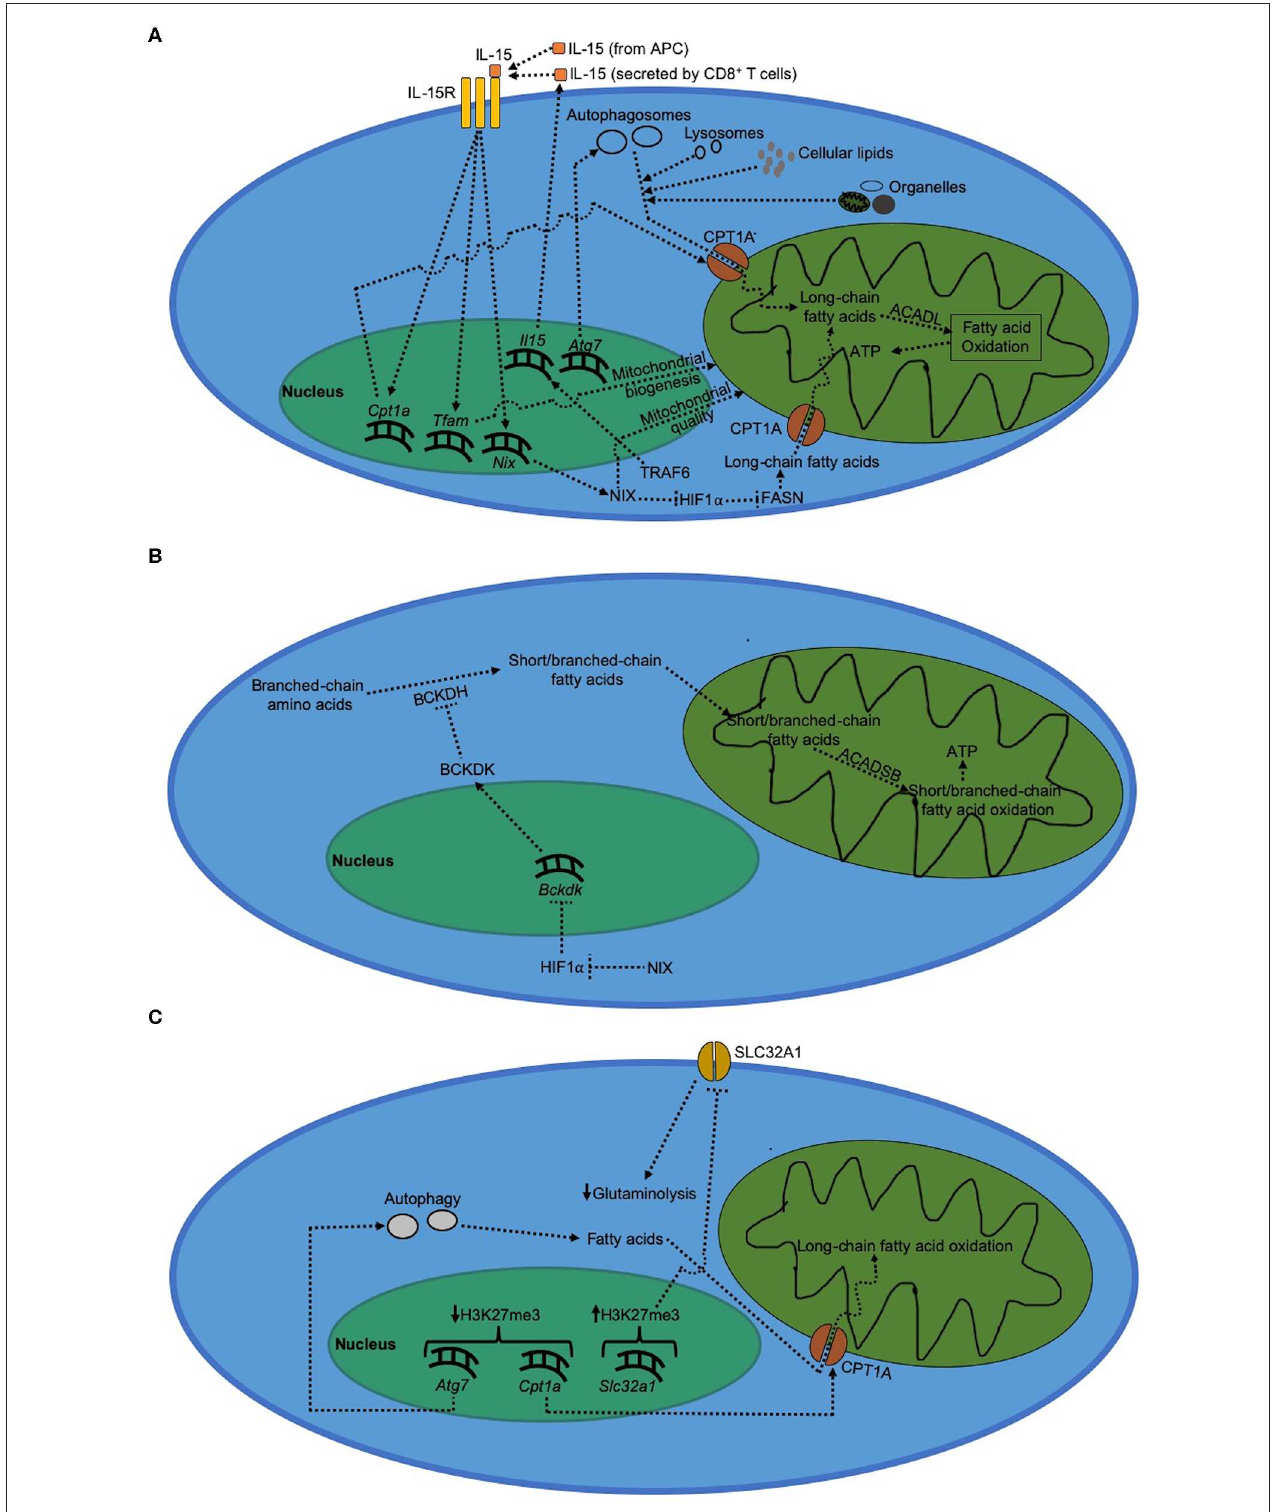
FIGURE 2 | Metabolism in CD8 + T cells during memory formation. (A) Regulation of long-chain fatty acid metabolism during CD8 + T cell during memory formation. Immunological memory formation is characterized by metabolic shift to fatty acid oxidation driven by long-chain fatty acids, which serves to primarily generate ATP. (B) Regulation of short/branched-chain fatty acid metabolism during CD8 + T cell memory formation. (C) Epigenetic regulation of metabolism during CD8 + T cell memory formation.